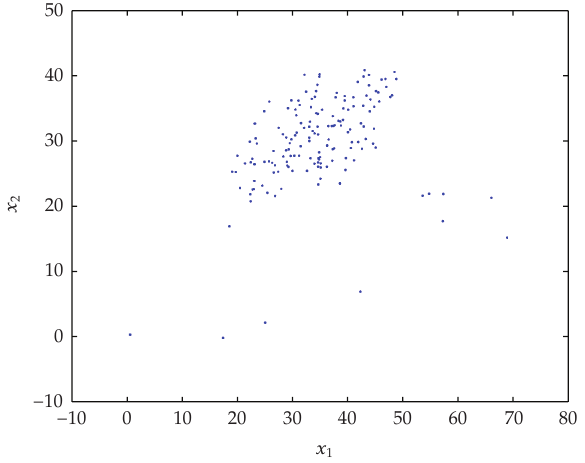
Figure 1: State responses of x 1 (cid:2) k (cid:3) and x 2 (cid:2) k (cid:3)